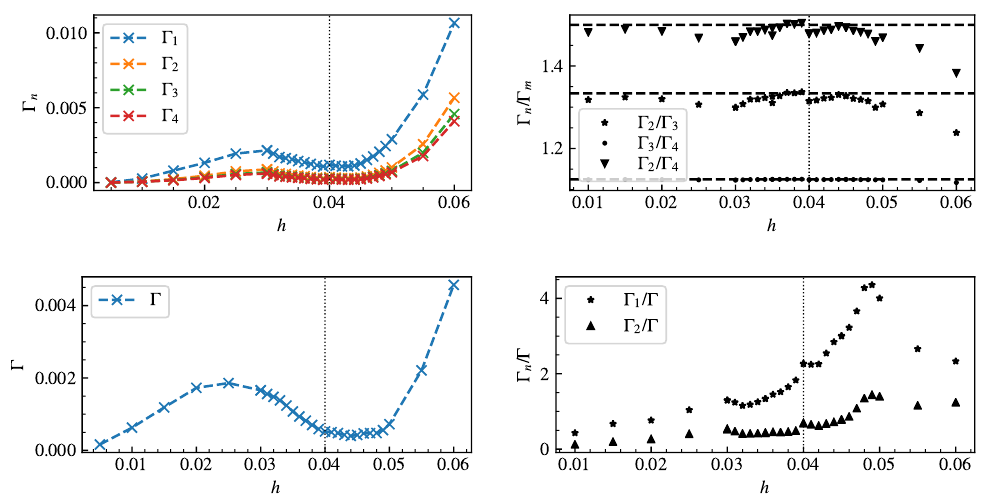
Figure B.1: Left panels: Entropy growth rates Γ (top) and magnetisation relaxation n rate Γ (bottom) in units J = 1 for longitudinal quenches in the quantum Ising spin chain starting from g = 1.25 as a function of the longitudinal coupling. Right: Ratios Γ / Γ / Γ (bottom). The dashed lines represent the universal ratios (4.4) (top) and Γ n m n that are restored in the limit h → 0. The vertical line is drawn at the value h where crit the second quasi-particle appears in the post-quench spectrum.